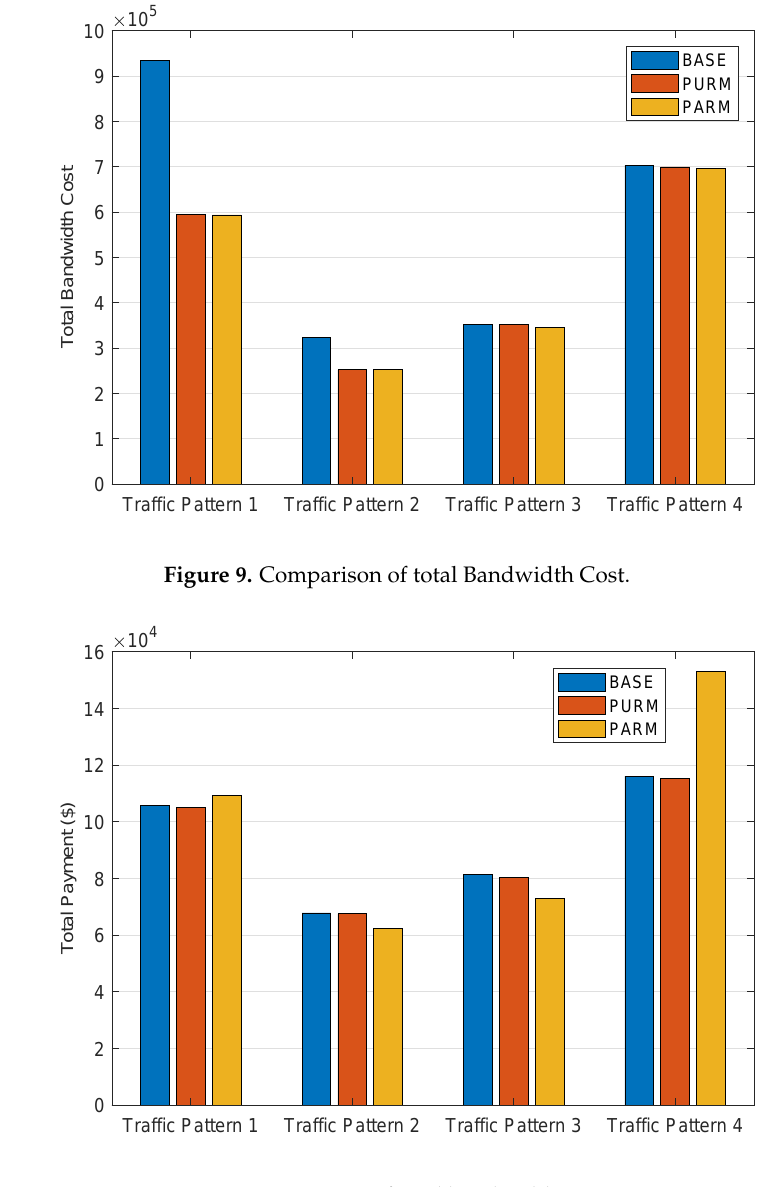
Figure 10. Comparison of total bandwidth